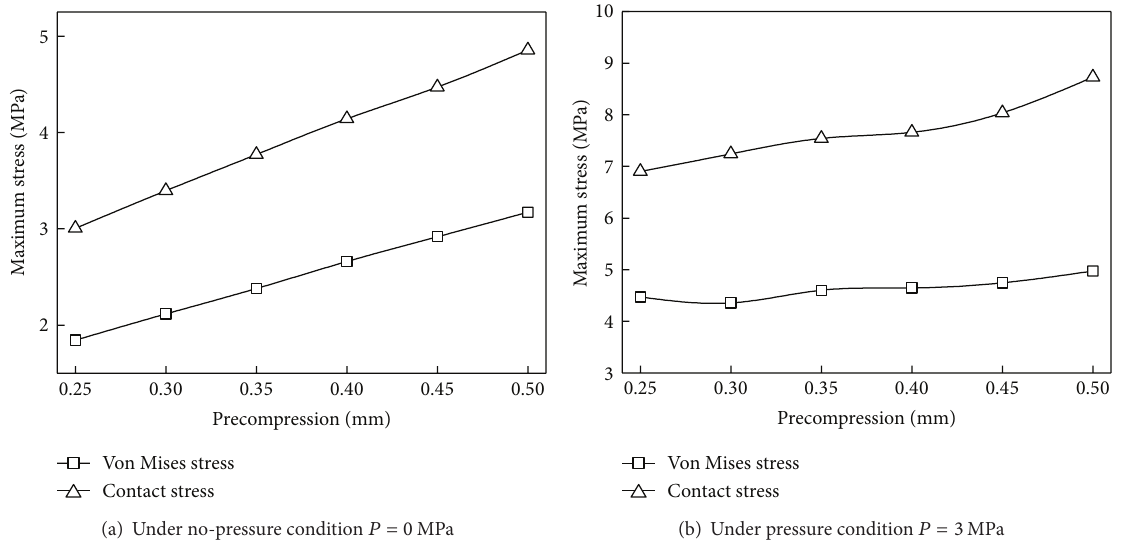
Figure 9: Stress of the biomimetic sealing ring under different